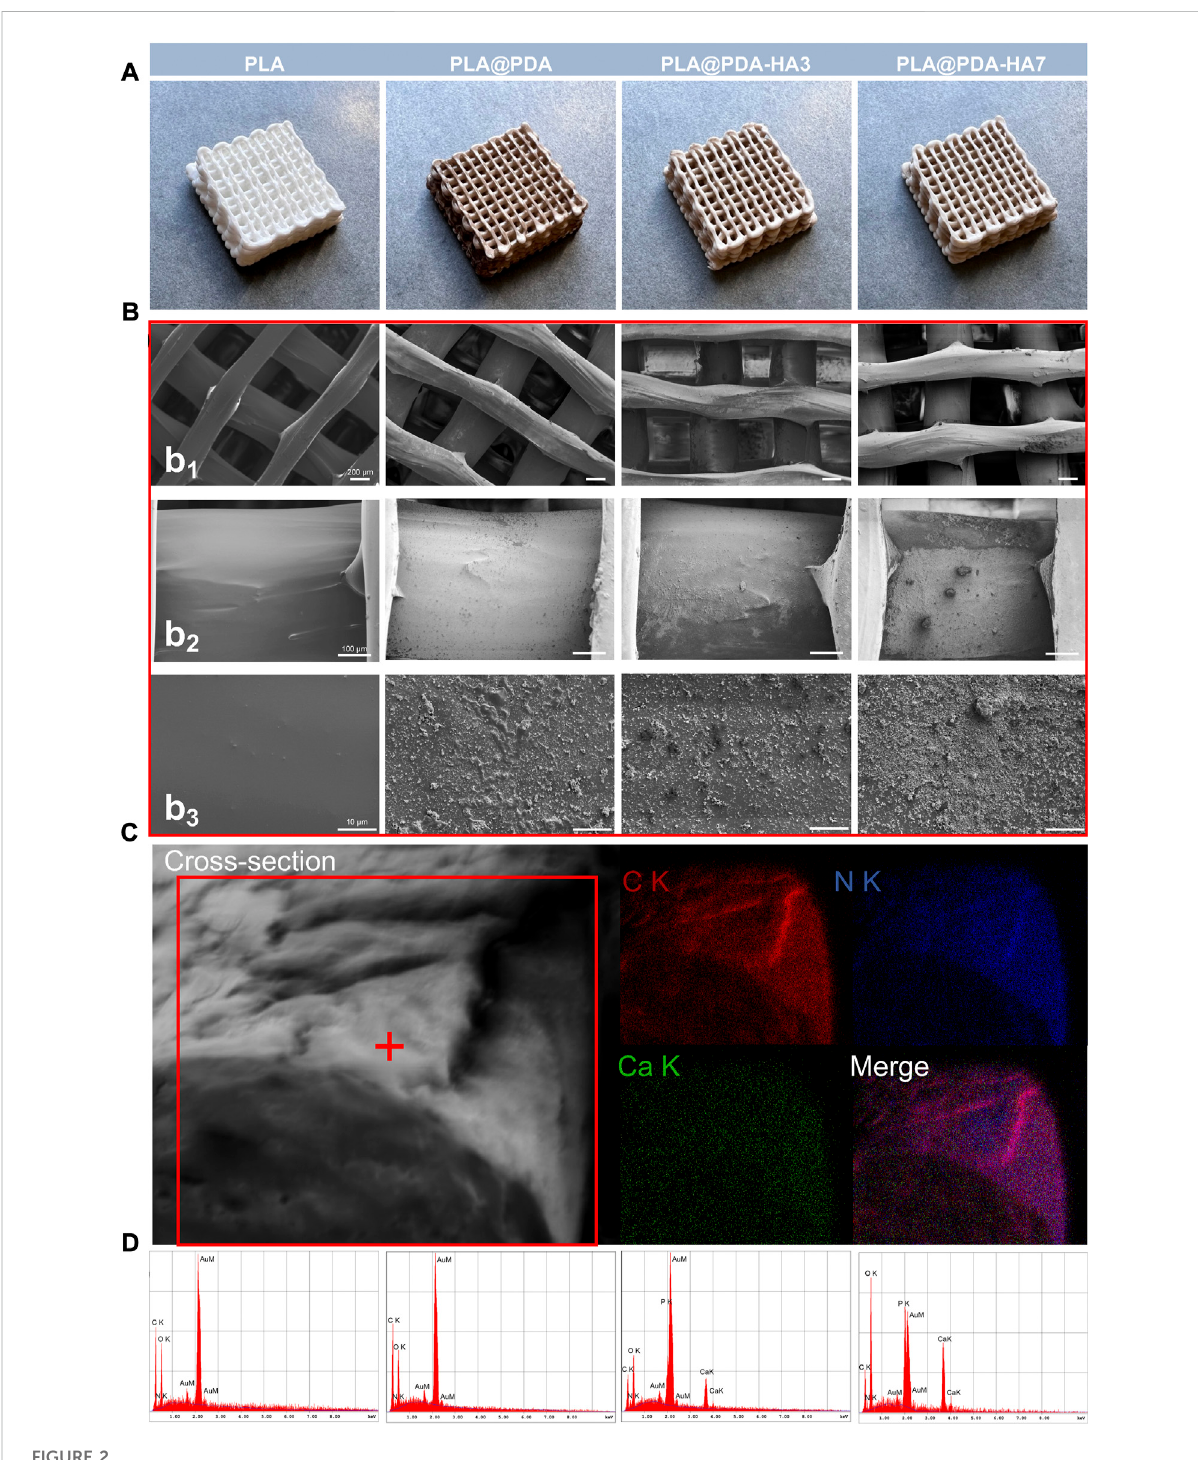
FIGURE 2 (A) Representative optical images of 3D printed PLA, PLA@PDA, PLA@PDA-HA3, and PLA@PDA-HA7 scaffolds; (B) Corresponding SEM images of surface topography of the fabricated scaffold within each group. Scale bar: Figure 2b 1 = 200 μ m, Figure 2b 2 = 100 μ m, Figure 2b 3 = 10 μ m; (C) Cross-sectional micromorphology of PLA@PDA-HA7 specimen and the corresponding EDX mapping. (Red: Carbon; Blue: Nitrogen; Green: Calcium). (D) Corresponding EDX analysis of each